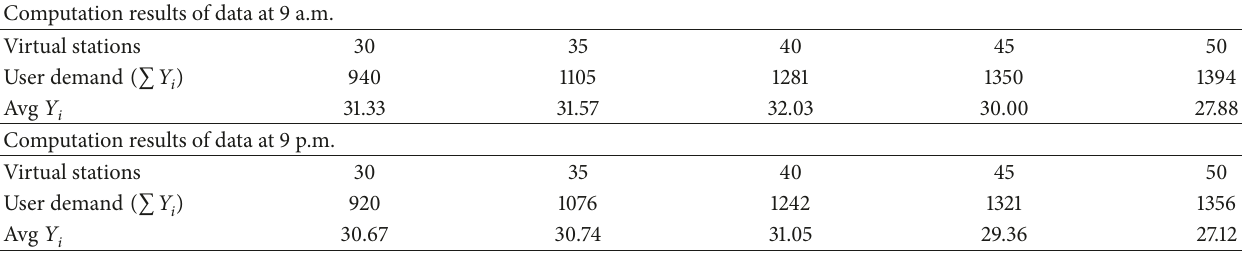
Table 5: Computation results of different quantities of virtual stations.